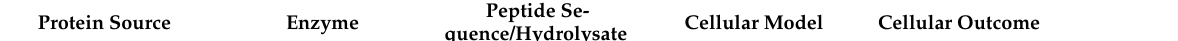
Table 6. Cellular antioxidant effects of cereal peptides and